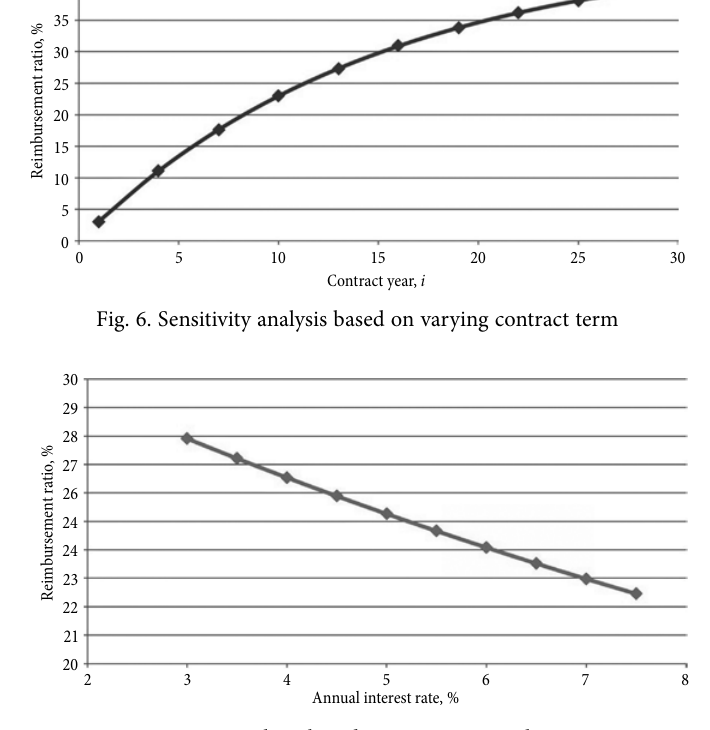
Fig. 7. Sensitivity analysis based on varying annual interest